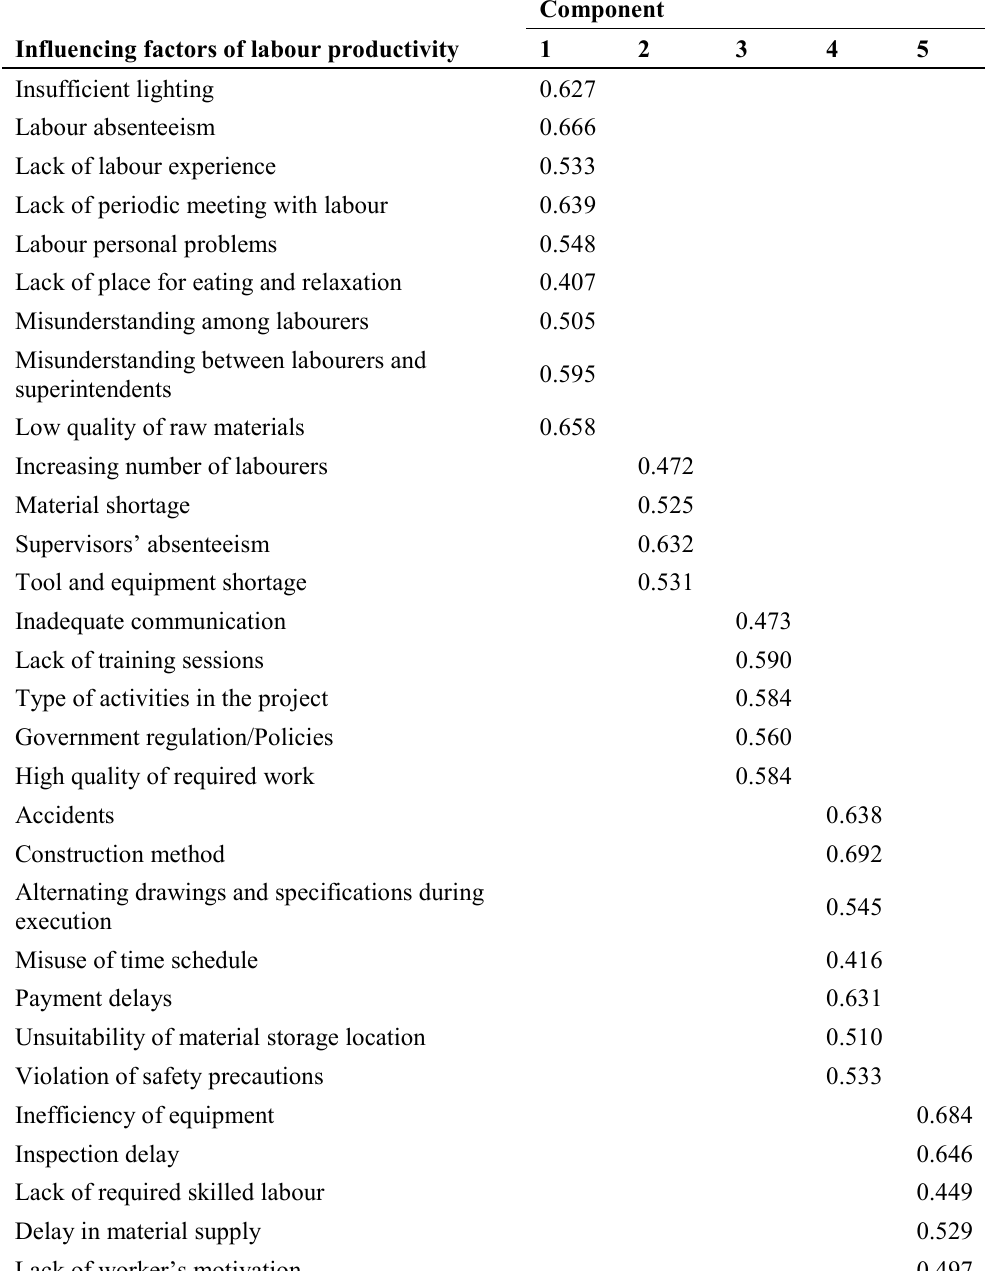
Table 5. Factors Affecting Labour Productivity